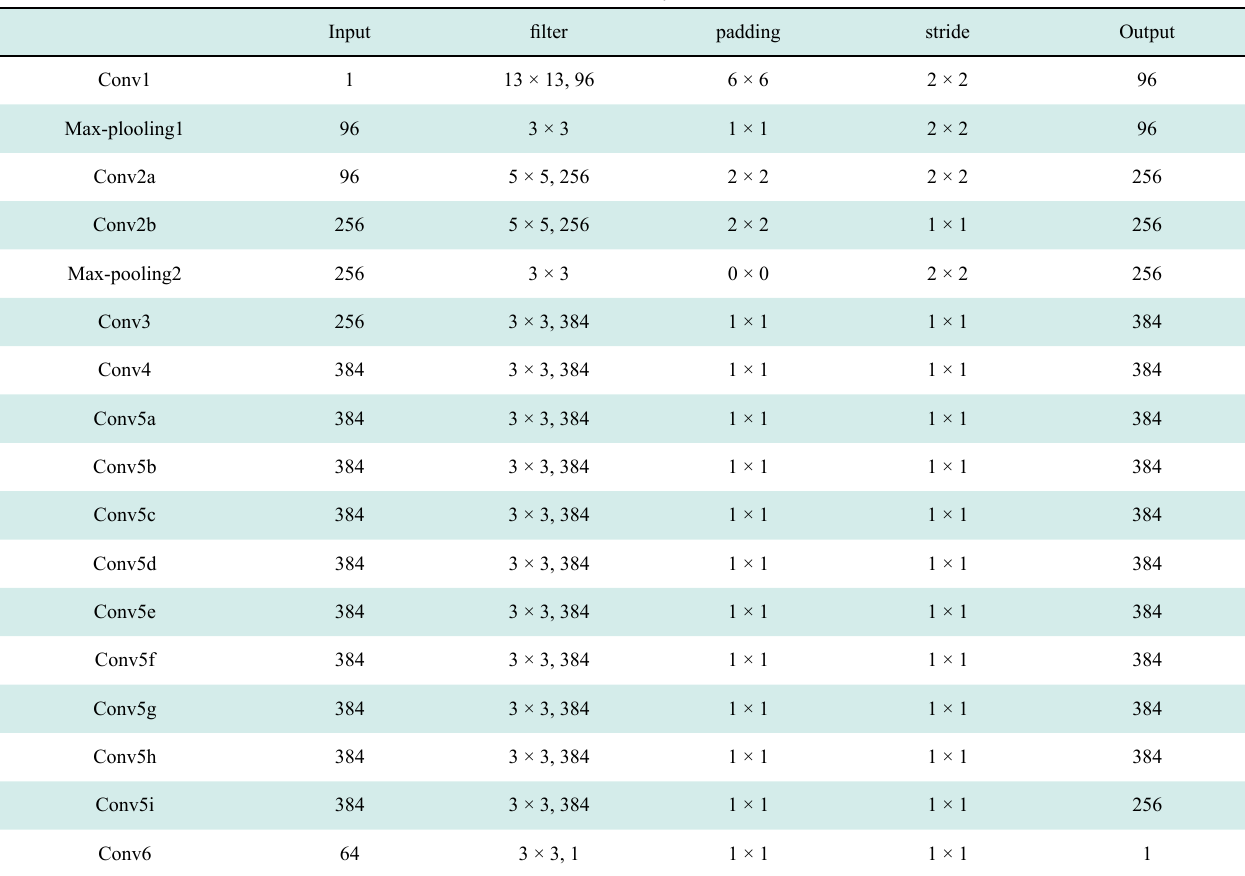
Table 1 Architecture of the convolutional neural network model used in this